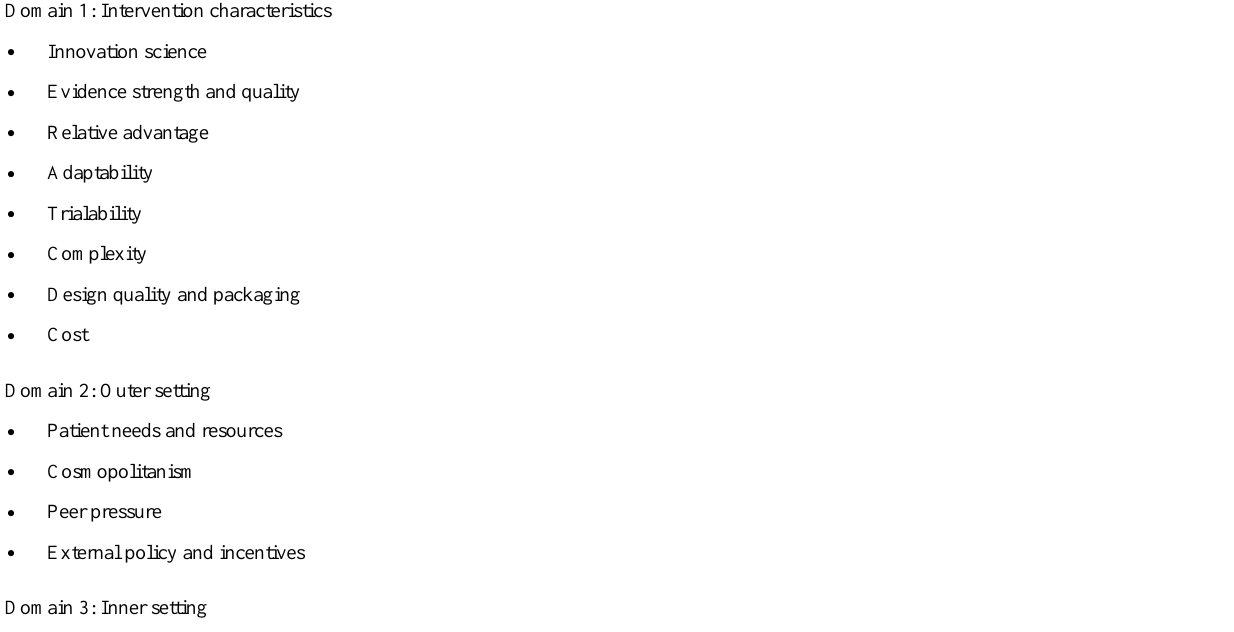
Textbox 1. Domains 1-4 in the Consolidated Framework for Implementation Research. Domain 1: Intervention